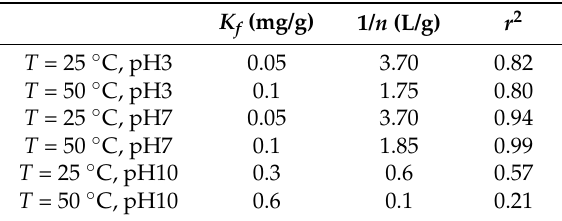
Table 4. Freundlich isotherm constants for the adsorption of MB onto the V 2 O 5 /PES